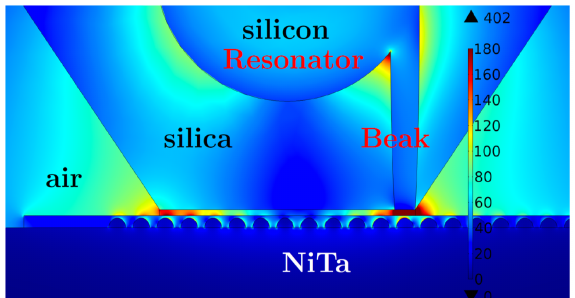
Figure 36. Electric field mapping below the LFDT, reprinted figure with permission from [189]. Copyright (2017) by the American Physical